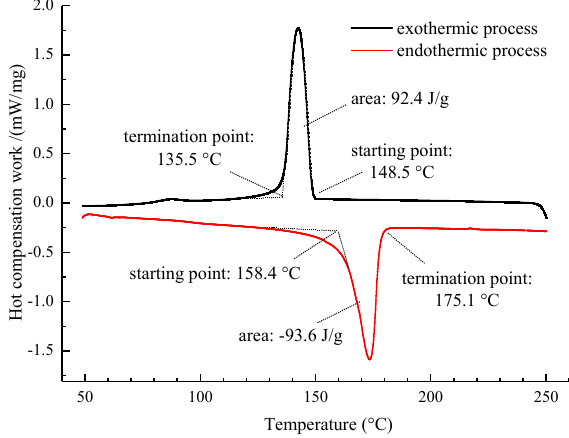
Figure 2. Differential scanning calorimetry (DSC) results for the PCTIA.